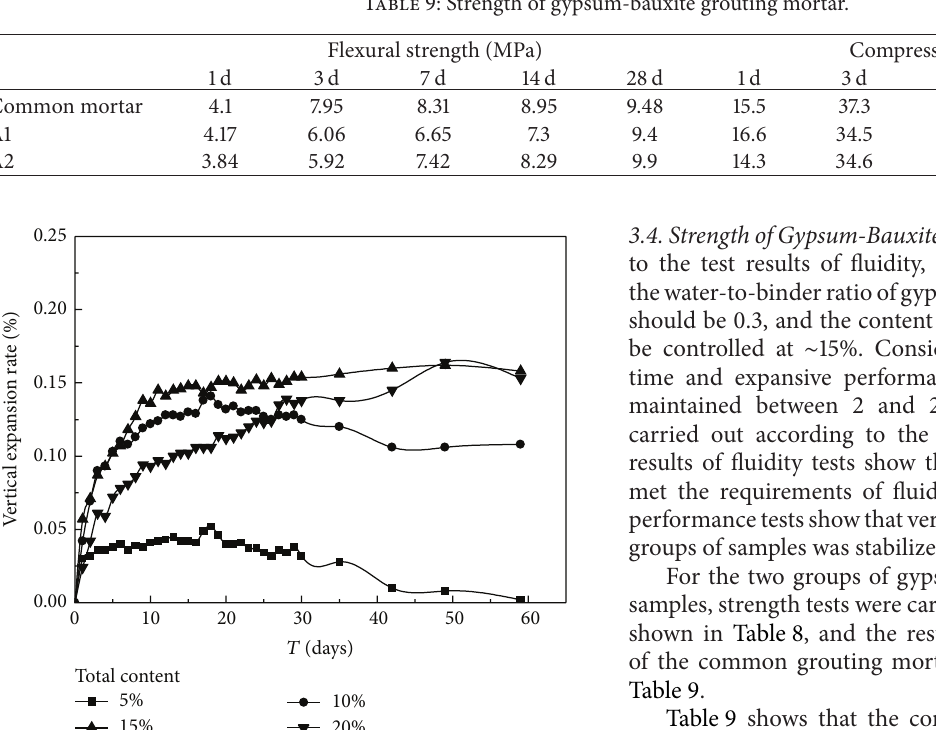
Table 9: Strength of gypsum-bauxite grouting mortar.